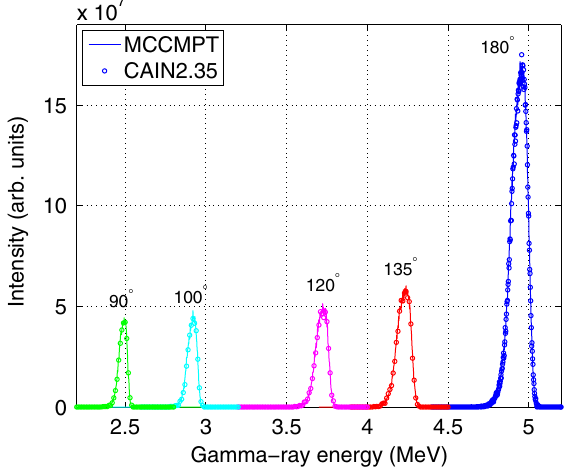
FIG. 12. Compton gamma-beam energy spectra for different collision angles 90 (cid:8) , 100 (cid:8) , 120 (cid:8) , 135 (cid:8) , and 180 (cid:8) . These spectra are simulated using codes MCCMPT and CAIN2.35 . The electron- beam and laser-beam parameters are the same as those in Fig. 10. The solid lines represent the spectra simulated using the code MCCMPT , and the circles represent the spectrum simulated using the code CAIN2.35 .